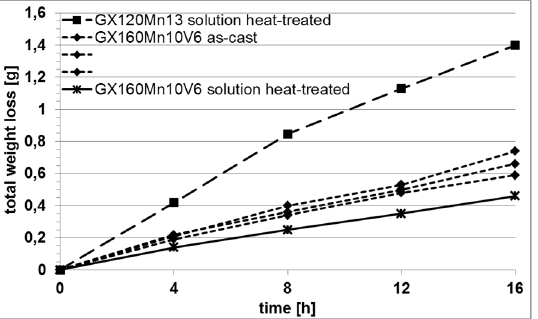
Figure 5. Abrasive wear response of Hadfield cast steel vs. high-manganese cast steel with the addition of 5.5% V, [6].